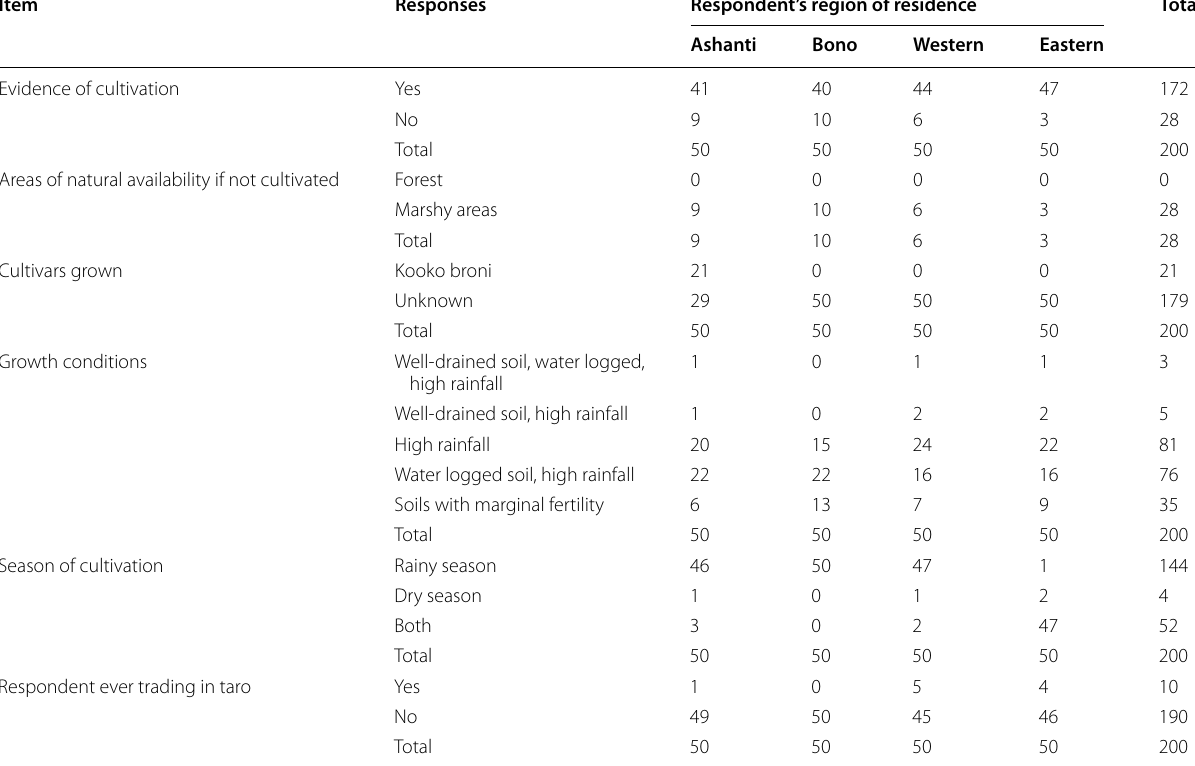
Table 3 Previous information on the availability, cultivation and utilization of taro in the study